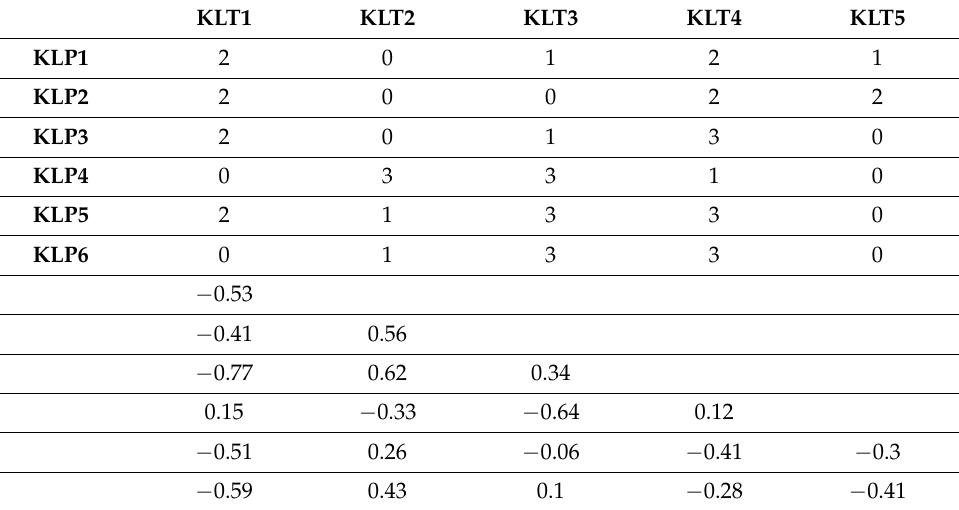
Table 13. The results of the similarity study on a cross-basis of the class set